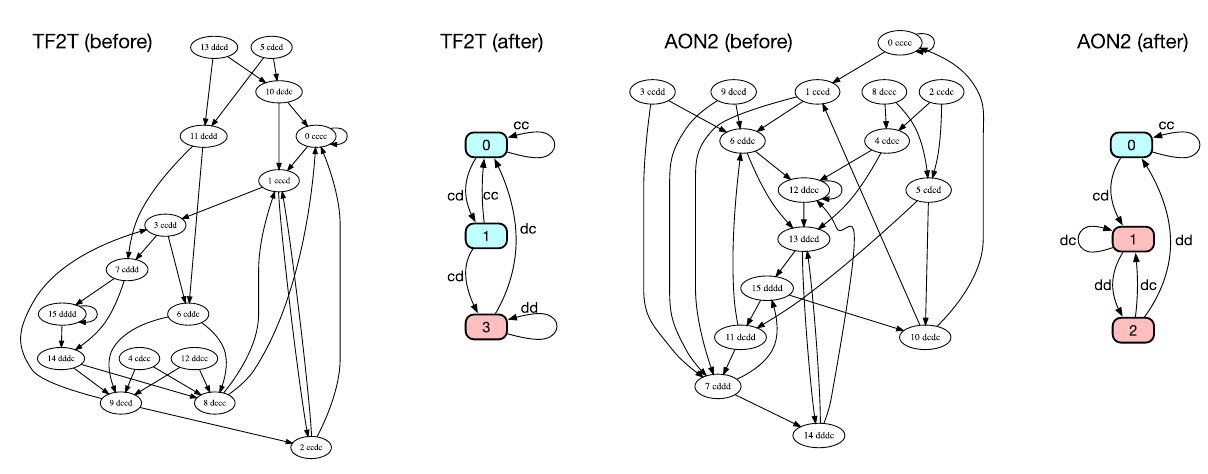
Figure 3. Conversion of history-based representation to state-based one. An example is Tit-for-Two-Tats (TF2T) before and after the DFA minimization (left) 5 . The second example on the right hand is AON 2 , the ‘all-or-none’ strategy for the PD game among memory-two players 32 . Each of these strategies, which generally has 16 nodes as a memory-two strategy, is reduced to an automaton with three internal states by the DFA minimization. As in Fig. 1, blue (red) means that the player should cooperate (defect) at the state. We have suppressed the action tuples assigned to the links in the history-based representation for better